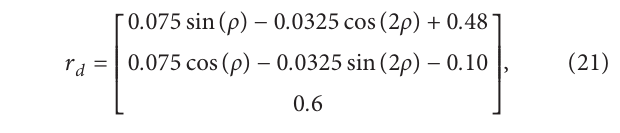
Table 3: Parameters involved in the simulative experiment. Parameters